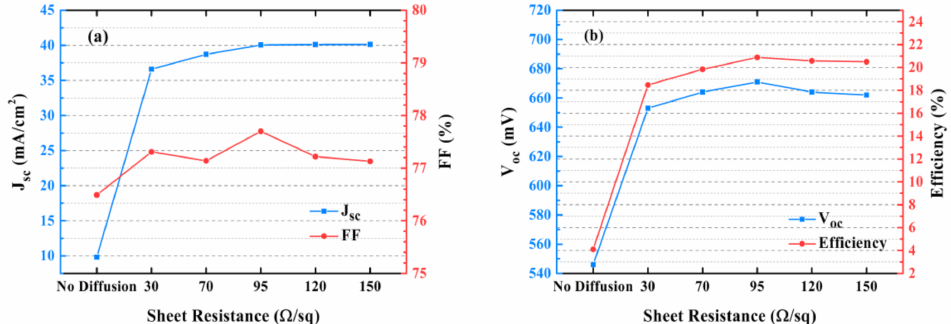
Figure 8. IBC solar cell performance parameters, ( a ) J sc and FF and ( b ) V oc and e ffi ciency, as extracted from the J-V characteristics of the best fabricated IBC cells with di ff erent front surface layer doping conditions (i.e., di ff erent front surface layer sheet resistances) measured under AM 1.5G, 0.1 W / cm 2 and 25 ◦ C. No di ff usion condition shows a control device made with no doped front surface layer. The active cell area was 2 × 2 cm 2 in all the cells.